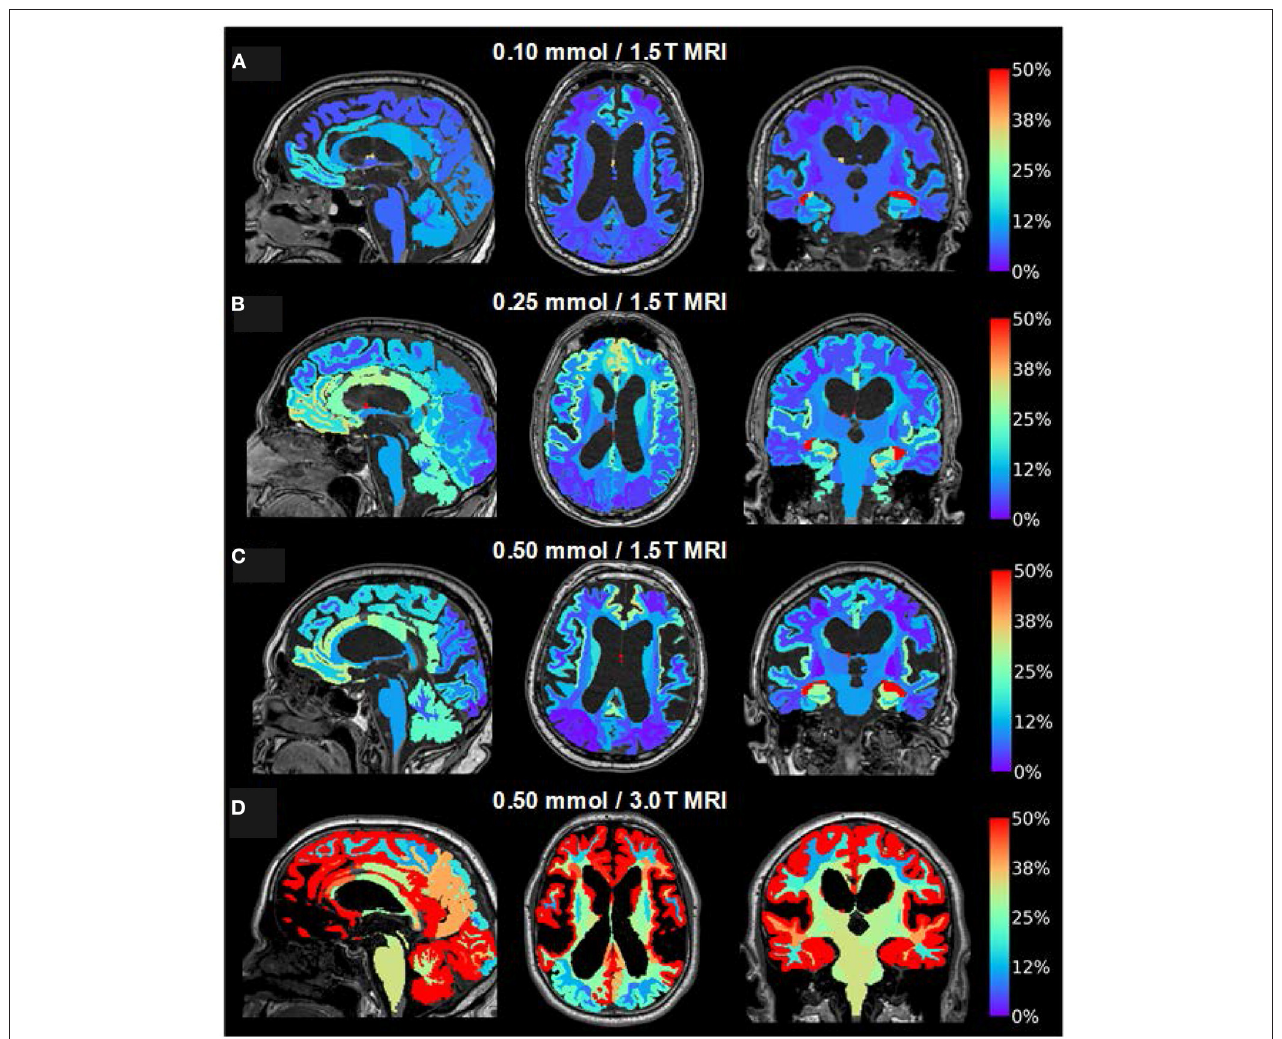
FIGURE 7 | Visualization of dose-dependent brain-wide tracer enrichment at group level 24h after intrathecal gadobutrol in the doses (A) 0.10 mmol (1.5T MRI; n = 18), (B) 0.25 mmol (1.5T MRI; n = 25), (C) 0.50 mmol (1.5T MRI; n = 19), and (D) 0.50 mmol (3T MRI; n = 33). The percentage change in the normalized T1 signal is indicated on the color bar to the